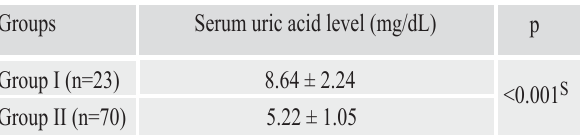
Table II: Comparison of hemodynamic status between two groups (N=93) Hemodynamic status